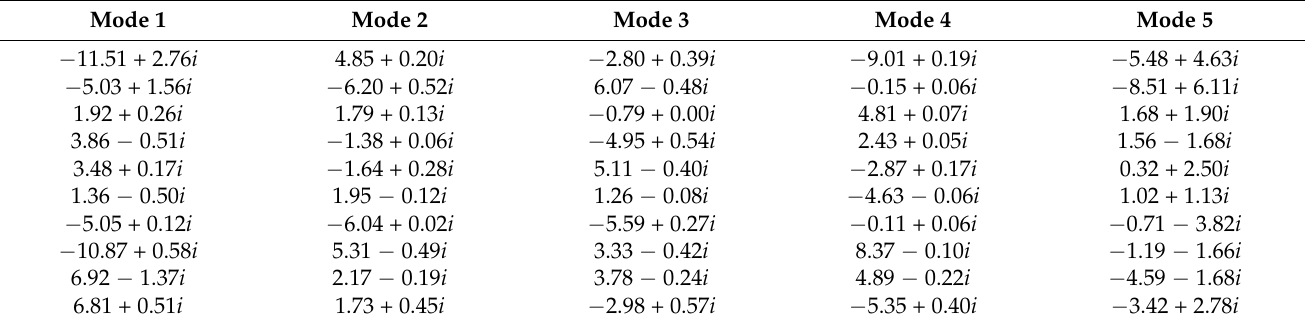
Table A5. Mode shape vector of UCBC #4 specimen. ( i : imaginary unit).